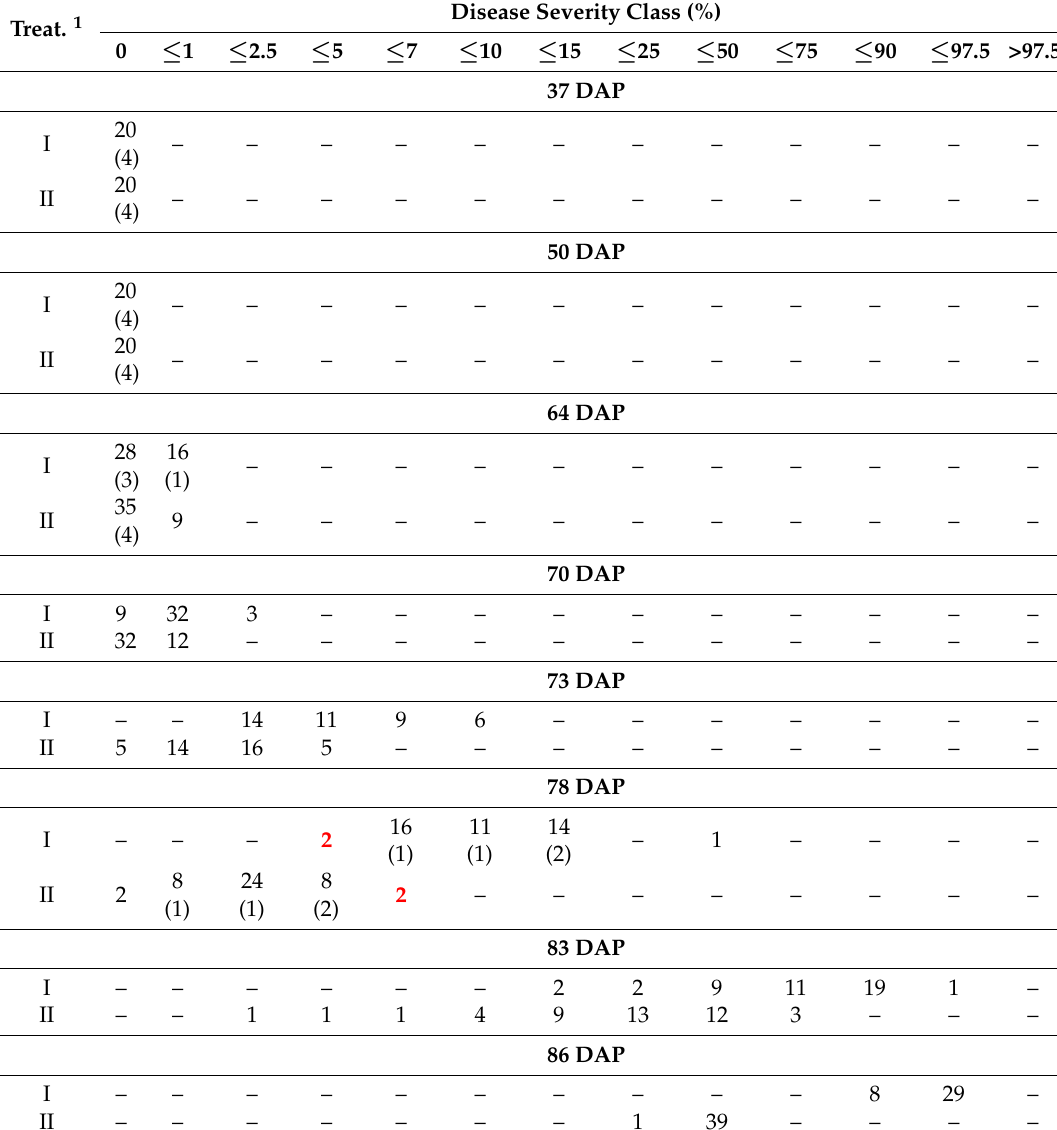
Table A5. Distribution of scores given at sampling unit level during disease assessment. Number of sampling units (SUs) assigned to a given class are indicated for each acquisition date, together with the number of imaged SUs using the spectral sensor in handheld mode (in parentheses). Numbers in red indicate SUs not used for evaluating the effects of different disease severity classes on the crop spectral response (see Section